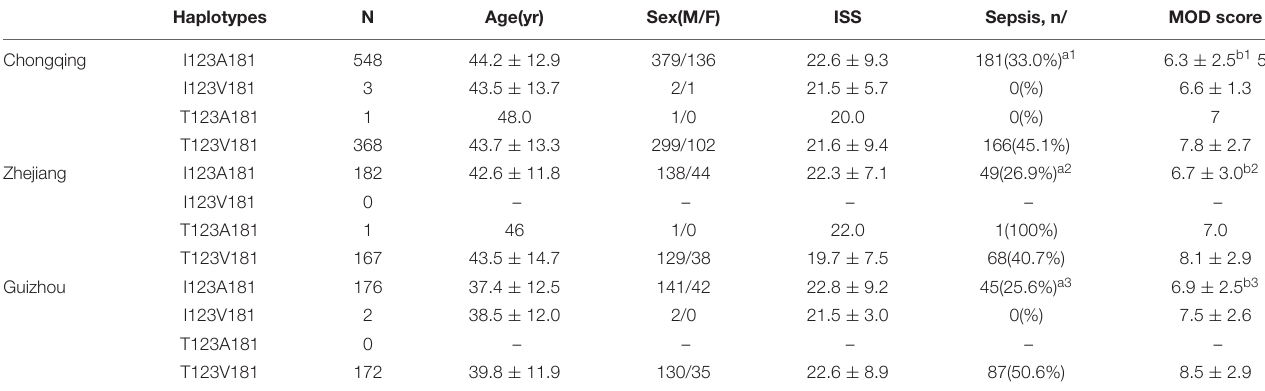
TABLE 3 | Haplotype effects of the I123T and A181V polymorphisms on the incidence of sepsis among trauma patients in three cohorts. Haplotypes N Age(yr) Sex(M/F) ISS Sepsis, n/ MOD score